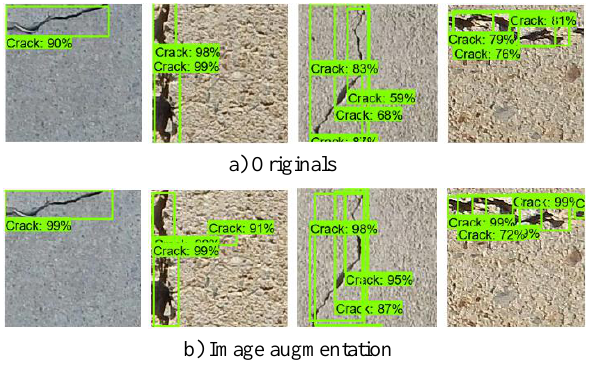
Figure 9. Detection results of crack.